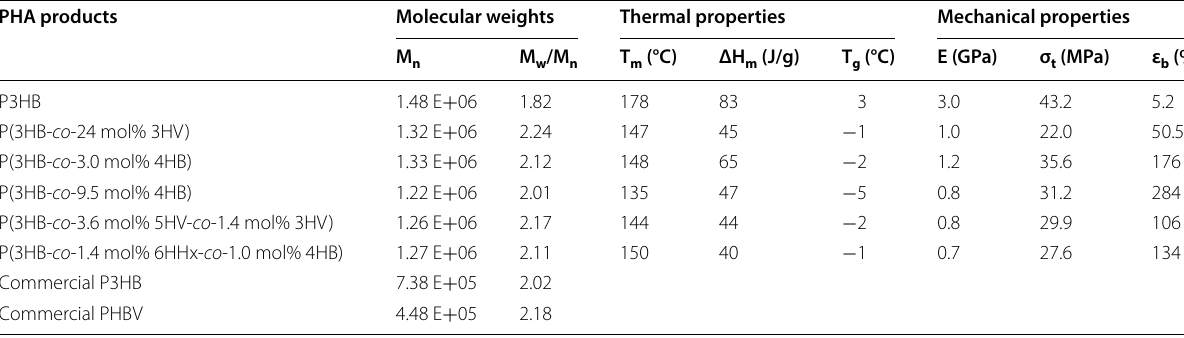
Table 2 Physical properties of the methanotroph produced PHA polymers